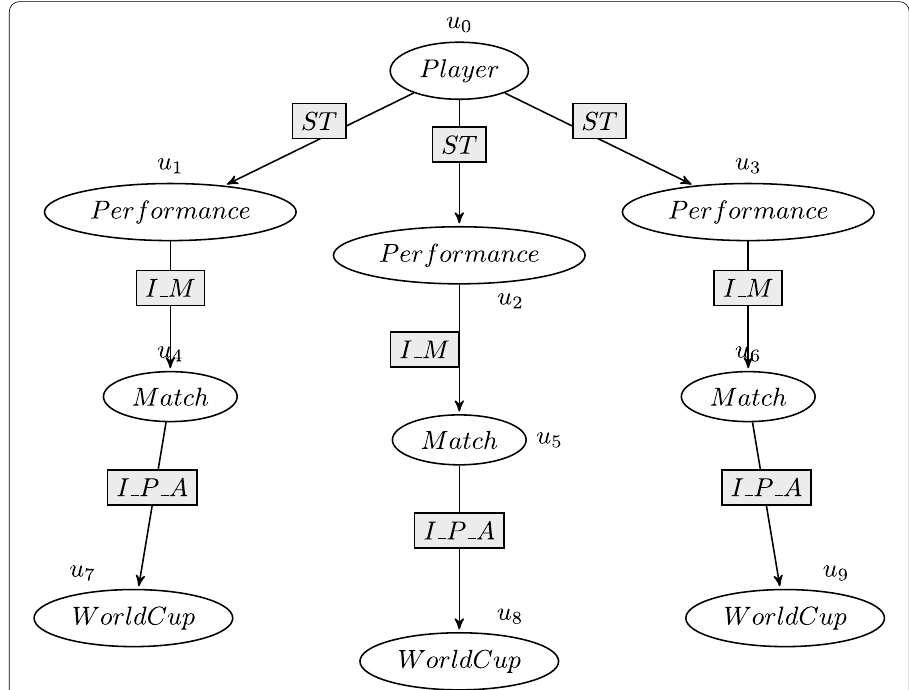
Fig. 7 An example for a tree query: “Find the players who participate in at least 3 different World Cup Tournaments in WorldCup Database” . The relationship “ ST ” stands for “ started”, “I_M ” stands for “ in match ” and “ I_P_A ” stands for “ is played at ”